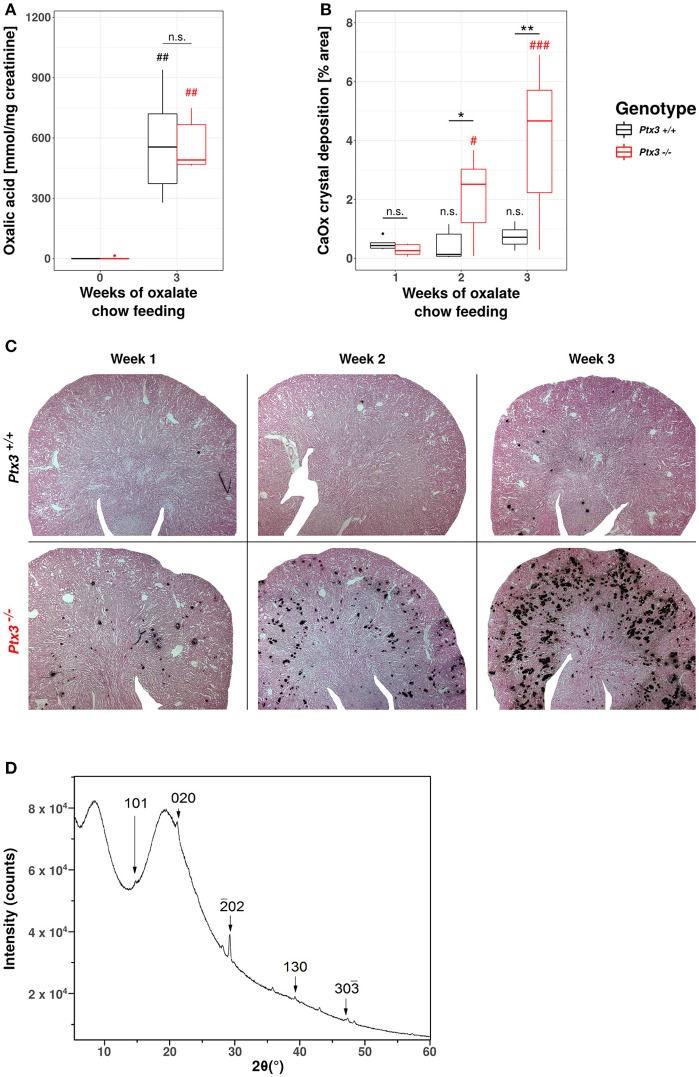
Lack of PTX3 induces hyperoxaluria-induced nephrocalcinosis in non-susceptible B6;129SV mice. Female PTX3-competent (Ptx3+/+) and -deficient (Ptx3−/−) animals with 10–12 weeks of age received oxalate chow for 3 weeks (n = 9). (A) Oxalic acid levels in urine at baseline and after 3 weeks of oxalate chow. (B) Quantification of calcium oxalate crystal deposition was conducted using Pizzolato's method on formalin fixed kidney sections as shown in (C). (D) Analysis of PTX3−/− kidneys by X-ray diffraction consistent with calcium-oxalate monohydrate crystals. Data are from four independent experiments. n.s., not significant; *p < 0.05, ** p< 0.01 vs. wild type and respective #, ##, and ### vs. week 1 as indicated.